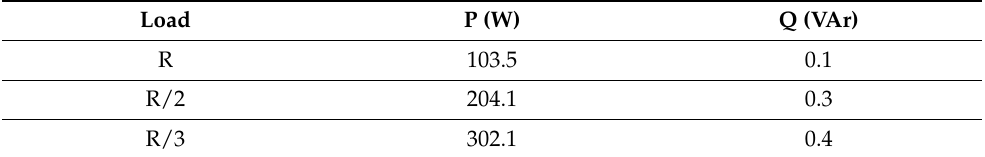
Table 2. Expected values for resistive loads from the acquired voltage and current signals.